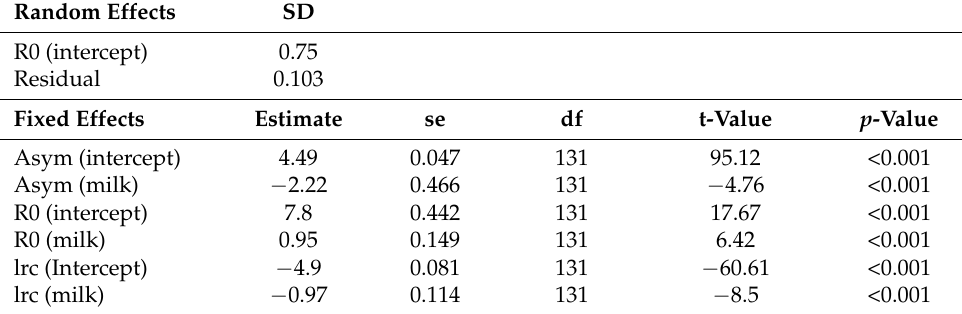
Table 2. Coefficients and statistics of an exponential asymptotic mixed linear model on pH controlling for product (milk, colostrum). The product reference is milk. Asym represents the horizontal asymptote; R0 is pH at t = 0; lrc is the natural logarithm of the rate